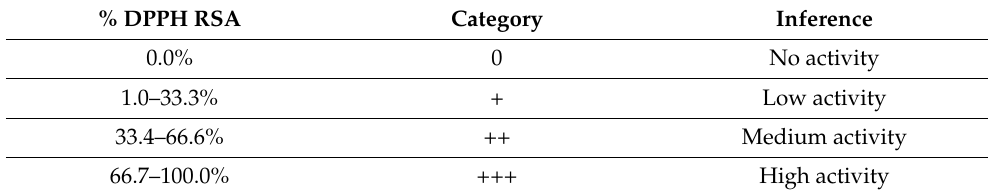
Table 3. Categories of antioxidant activity for individual bands based on DPPH %